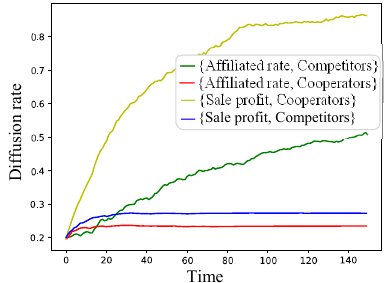
Figure 9. Results in small world network.